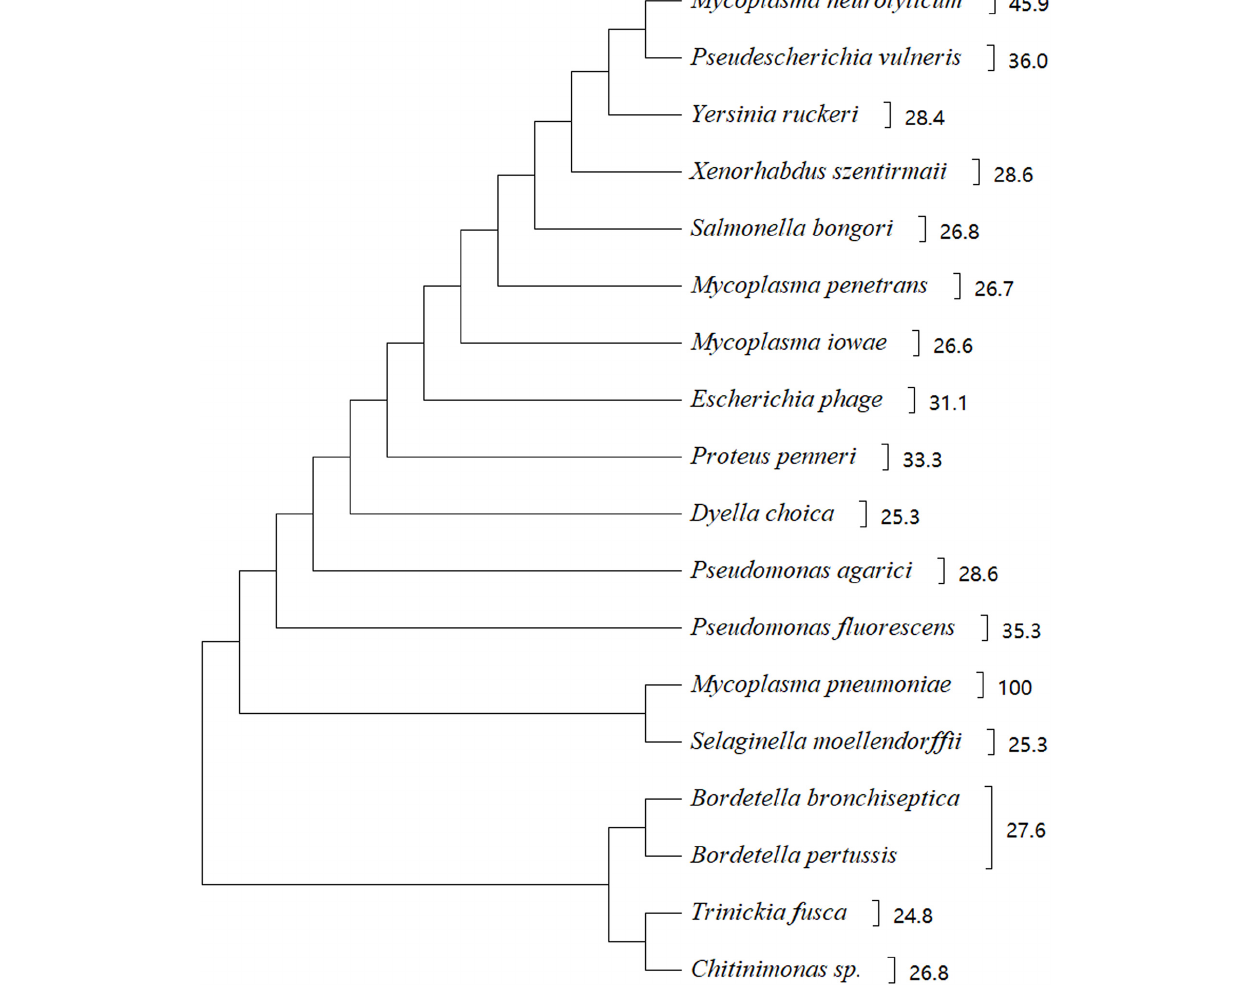
FIGURE 2 | Phylogenetic tree showing the homology between CARDS TX and other bacterial proteins. There were 18 strains with a score of 110 or more selected from https://www.uniprot.org/blast. The phylogenetic tree shows 18 species of microorganisms that are highly homologous to CARDS TX, such as Mycoplasma neurolyticum, Mycoplasma iowae, Mycoplasma penetrans , and others. CARDS TX of M. pneumoniae is highly homologous with ADP-ribosylating toxin CARDS TX of M. neurolyticum . The evolutionary history of CARDS TX was examined using the Maximum Parsimony method. Evolutionary analyses were conducted